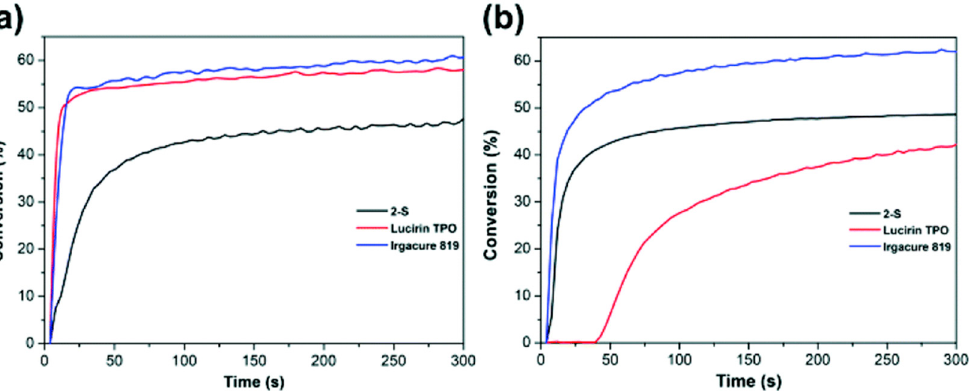
Figure 22. Polymerization profiles of TMPTA using 2-S, BAPO and TPO as photoinitiators (C = 2.7 × 10 − 5 mol.g − 1 resin), upon irradiation at ( a ) 405 nm and ( b ) 450 nm with LEDs (I = 30 mW cm − 2 ). Reproduced with permission of Ref. [191] .